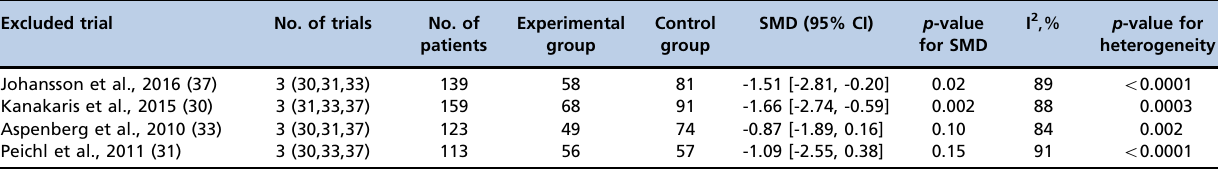
SMD, standardized mean